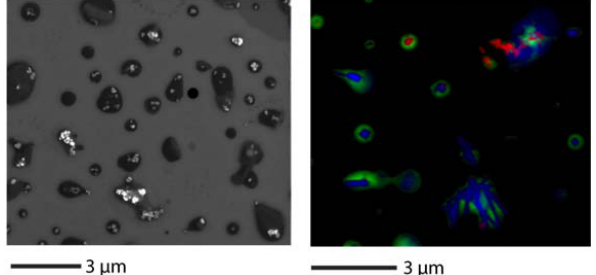
Fig. 17. SEM (left panel) and STXM (right panel) images show- ing internal heterogeneity of particles collected in CARES study. STXM maps derived by singular value decomposition depict or- ganic dominant phase (green), inorganic dominant phase (blue) and elemental carbon (red). Images are not from the same sample re-